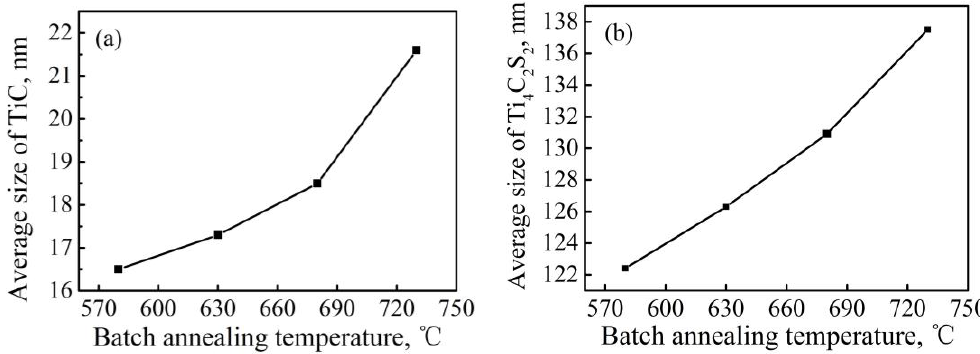
Figure 6. Effect of the batch annealing temperature on the average sizes of TiC ( a ) and Ti 4 C 2 S 2 ( b ).